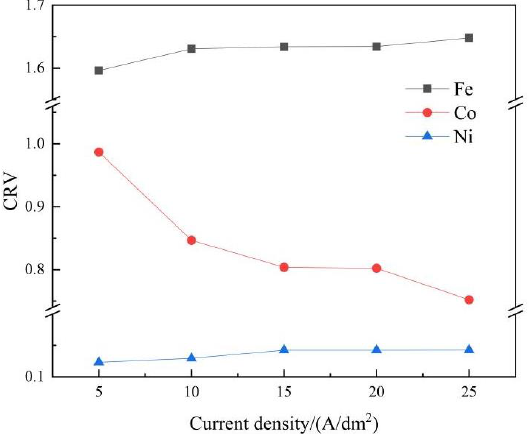
Figure 9. Evolution of the CRV of Fe, Ni, and Co according to applied current density. Concentrations of ionic species in the vicinity of the cathode surface are important for electrodeposition [61]. Figure 10 describes the metal ions and hydrogen atom distribu- tion near the cathode surface. It can be observed that the concentrations of Co 2+ and Ni 2+ decreased with increasing applied current density. It was also found that the Co 2+ and Ni 2+ concentrations near the cathode surface were much lower than those in the electrolyte, while the Fe 2+ concentration profile showed the reverse trend. At higher current densities, the hydrogen evolution reaction was more severe. Thus, the cathode surface was covered by hydrogen atoms, which in turn blocked the adsorption of metal ions [65]. Furthermore, the ion near the cathode surface was depleted at a rapid rate [15] as the applied current density increased; therefore, less cobalt and nickel were deposited. In contrast, industrial pure iron was employed as a soluble anode, and the Fe 2+ in the electrolyte was able to be